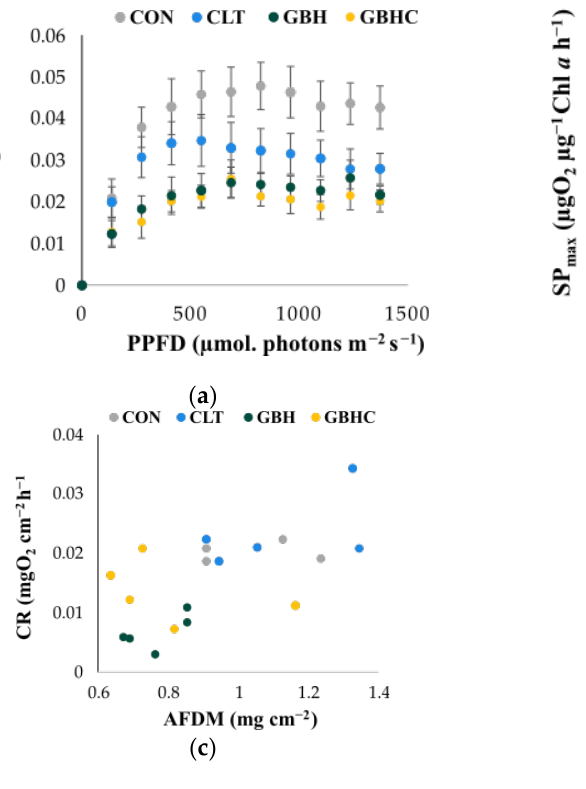
rate (SP max ); and phytobenthic community oxygen consumption where ( c ) areal-based community